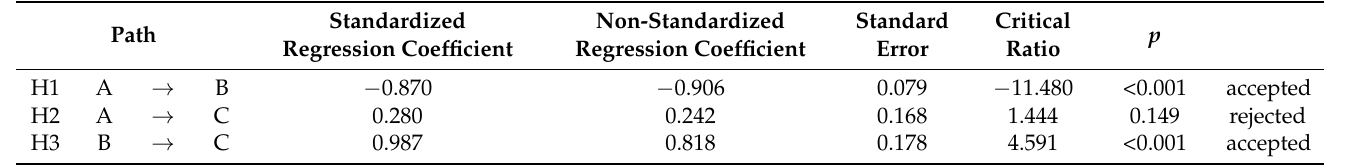
Table 7. Result of the path